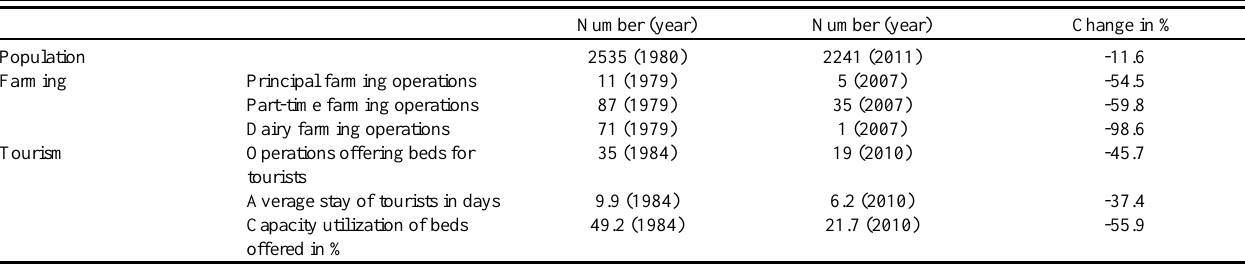
Table 2 . Trends in population, farming, and tourism in Bad Rippoldsau-Schapbach (source: Statistisches Landesamt Baden- Württemberg 2012).